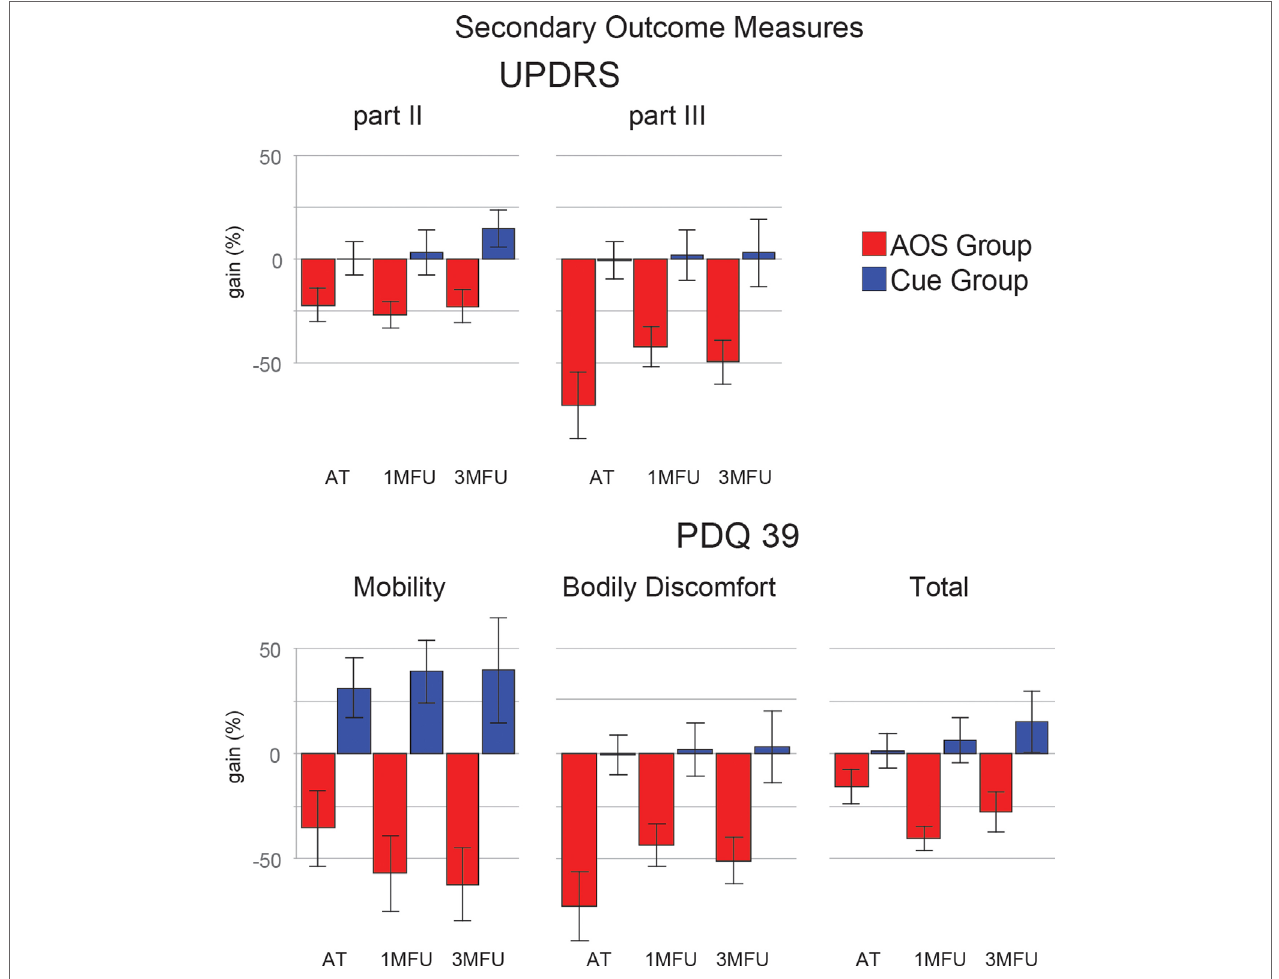
FiGUrE 3 | Improvement (gain) of the two groups in five secondary outcome measures [Unified Parkinson’s Disease Rating Scale: parts II and III (UPDRS) and Parkinson’s disease questionnaire 39 (PDQ39): mobility, bodily discomfort, and the total score], at the three evaluation times. Error bars are 1